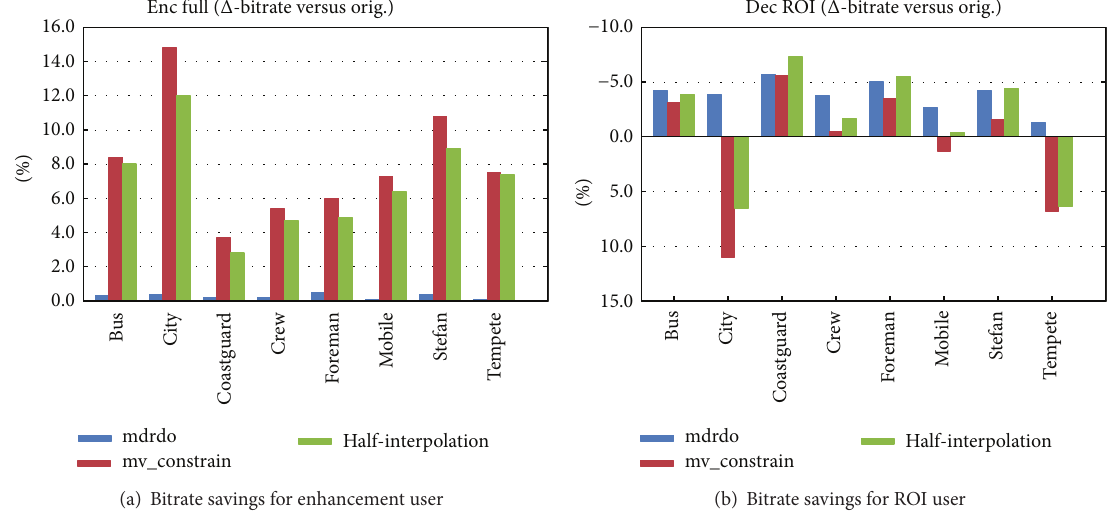
Figure 6: RD performance for spatial SVC.